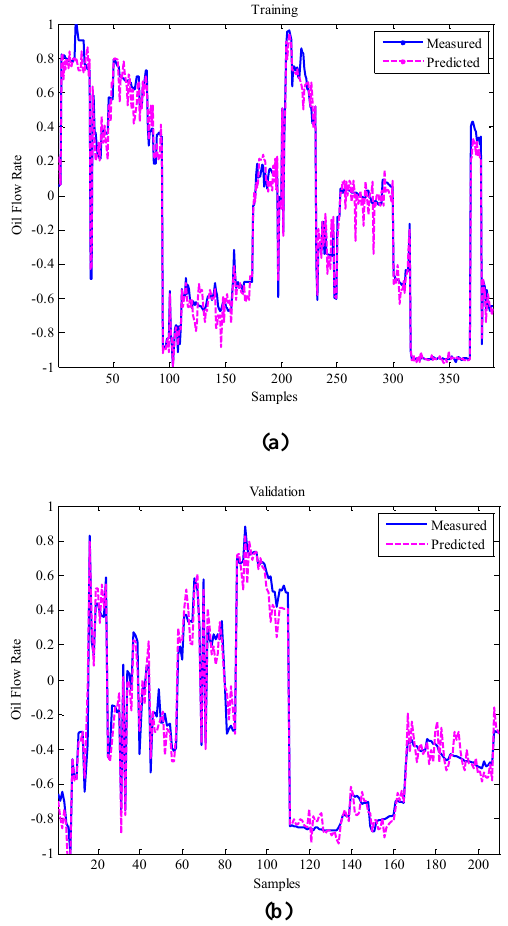
Fig. 7. Comparison between measured and predicted oil flow rate for ANFIS-ICA model, (a) training, (b) validation.